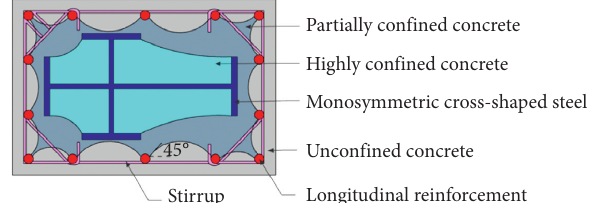
Figure 7: Materials in the cross section of an